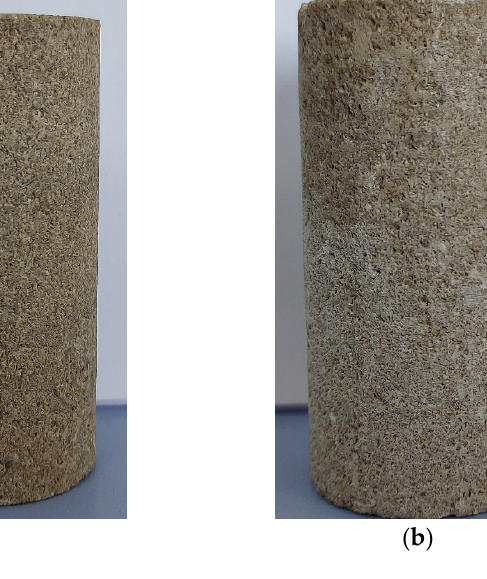
Figure 8. Used core samples from ( a ) CF-1, ( b ) CF-2, and ( c ) CF-3. two negative salinity gradient cases. It can be seen that negative salinity gradient cases